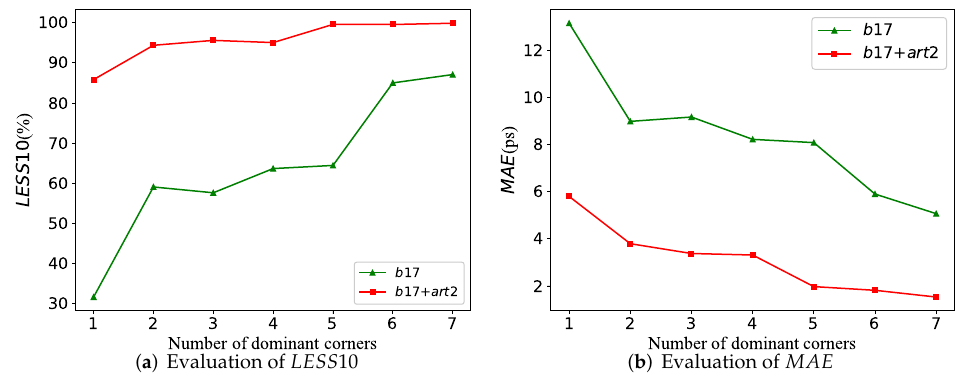
Figure 9. Performance evaluation of incremental re-training. Subfigure ( a ) shows the evaluation of LESS 10 of our model on art1 . Subfigure ( b ) shows the evaluation of MAE of our model on art1 . The green line represents that the training data only comes from b17 , while the red line is from b17 and art2